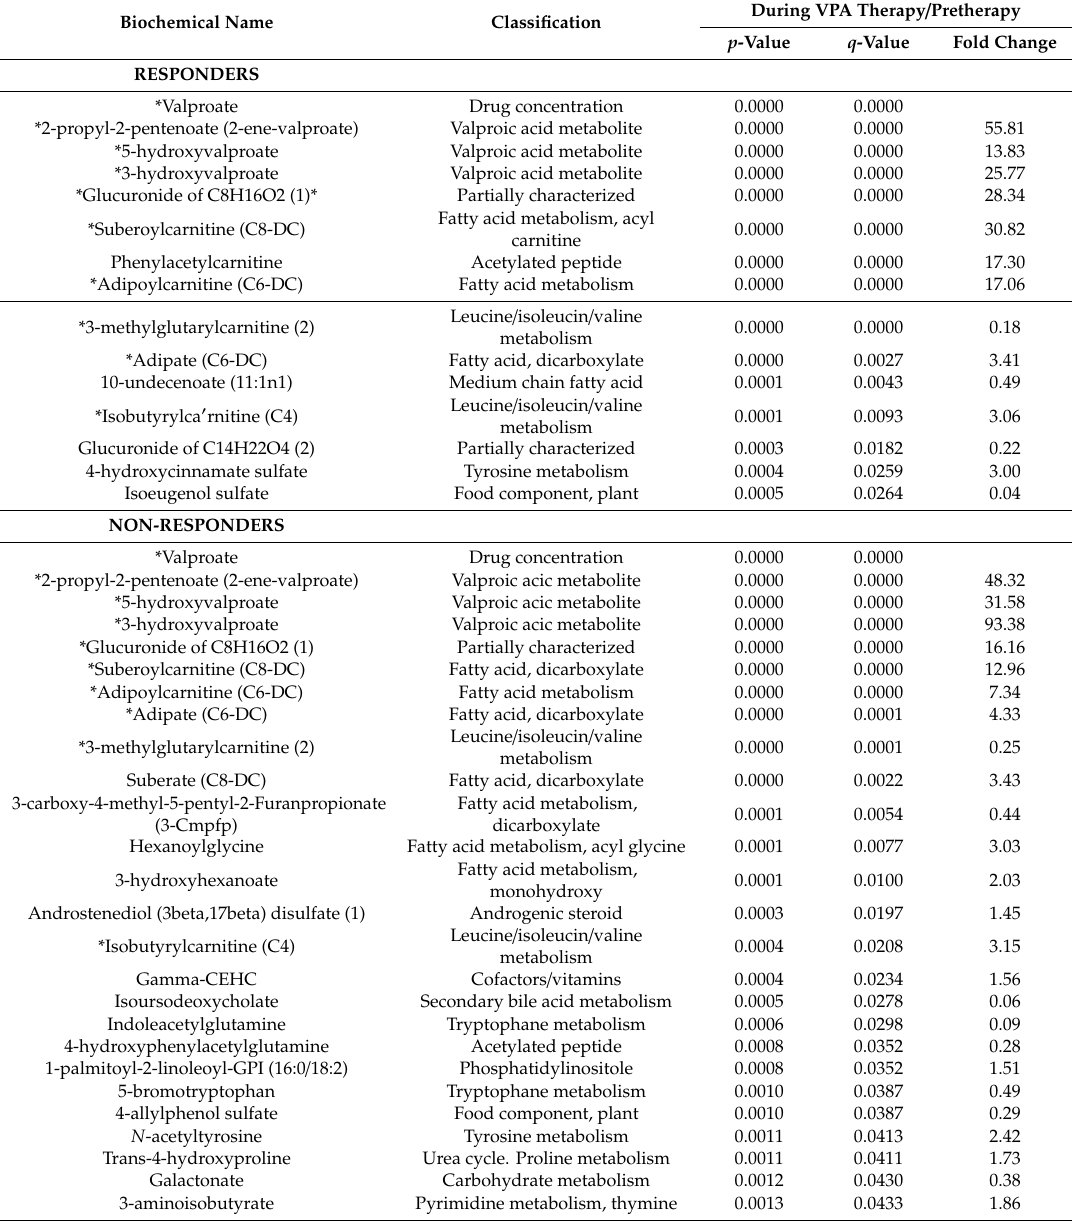
Table 1. An overview of significantly altered serum metabolites ( p < 0.05 and q < 0.05) after seven-day valproic acid